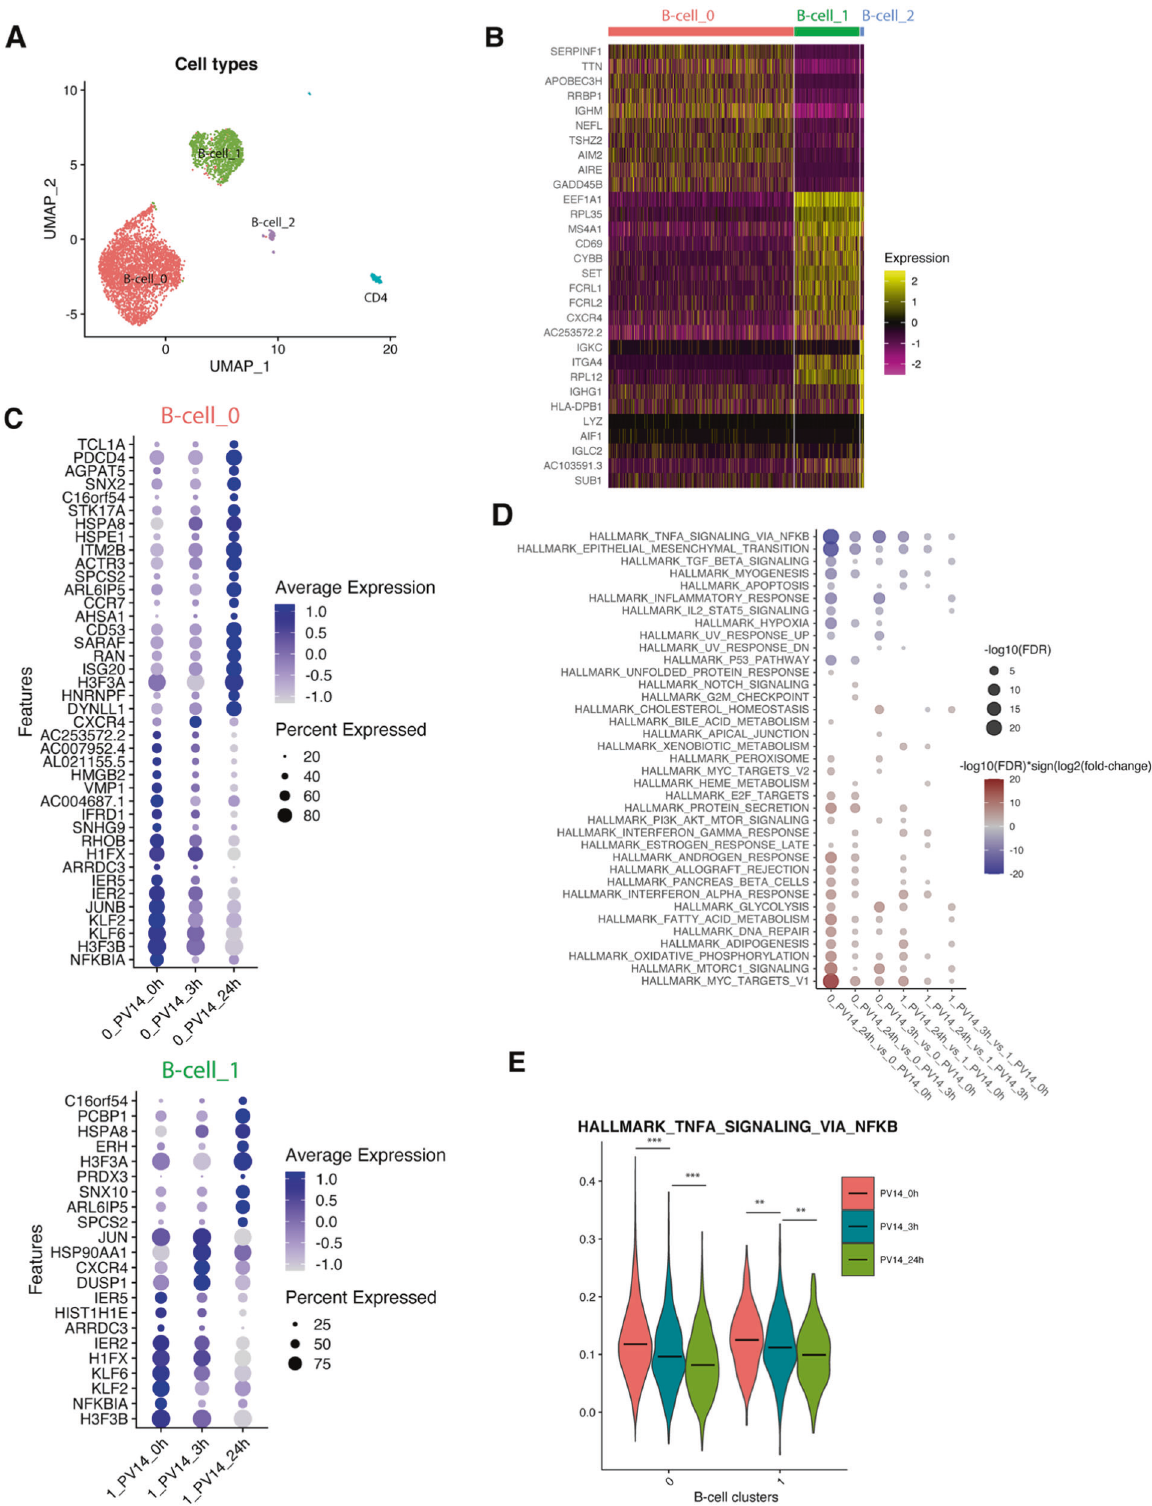
Fig. 3 scRNA-seq pro fi ling of immune cells in MCL. A UMAP (uniform manifold approximation and projection) visualization of all immune cells colored by immune cell type. B Heat map showing scaled expression of the top 10-fold change ranked marker genes of each B cell cluster. C Dot plots show the expression levels of signature genes of each condition within B-cell_0 and B-cell_1 clusters. The size of the dot encodes the percentage of cells expressing each gene and the color encodes the average expression level. D Dot plots show the statistical differences of pathway enrichment scores between two times in B-cell_0 and B-cell_1 clusters, respectively. The size of the dot encodes the FDR between two time points, while the color encodes the directions of changes by multiplying the FDR values with the sign of the log 2 fold changes. Red indicates a higher enrichment score in the fi rst condition of the comparison indicated at x axis. E Violin plots show the comparisons of enrichment scores of the HALLMARK_TNFA_SIGNALING_VIA_NFKB pathway of cells across three time points within B-cell_0 and B-cell_1 clusters. The Wilcoxon signed-rank test (two-sided) with FDR are shown. **FDR < 0.01, ***FDR <